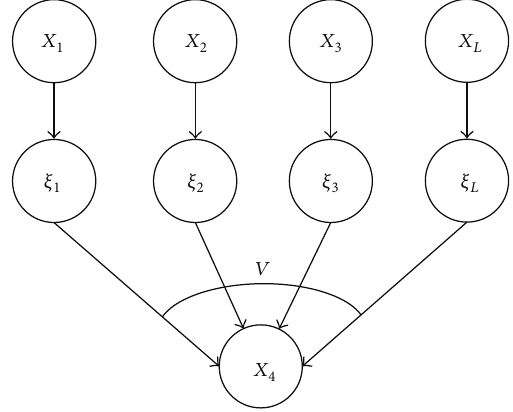
Figure 3: A diagram of leaky noisy-or